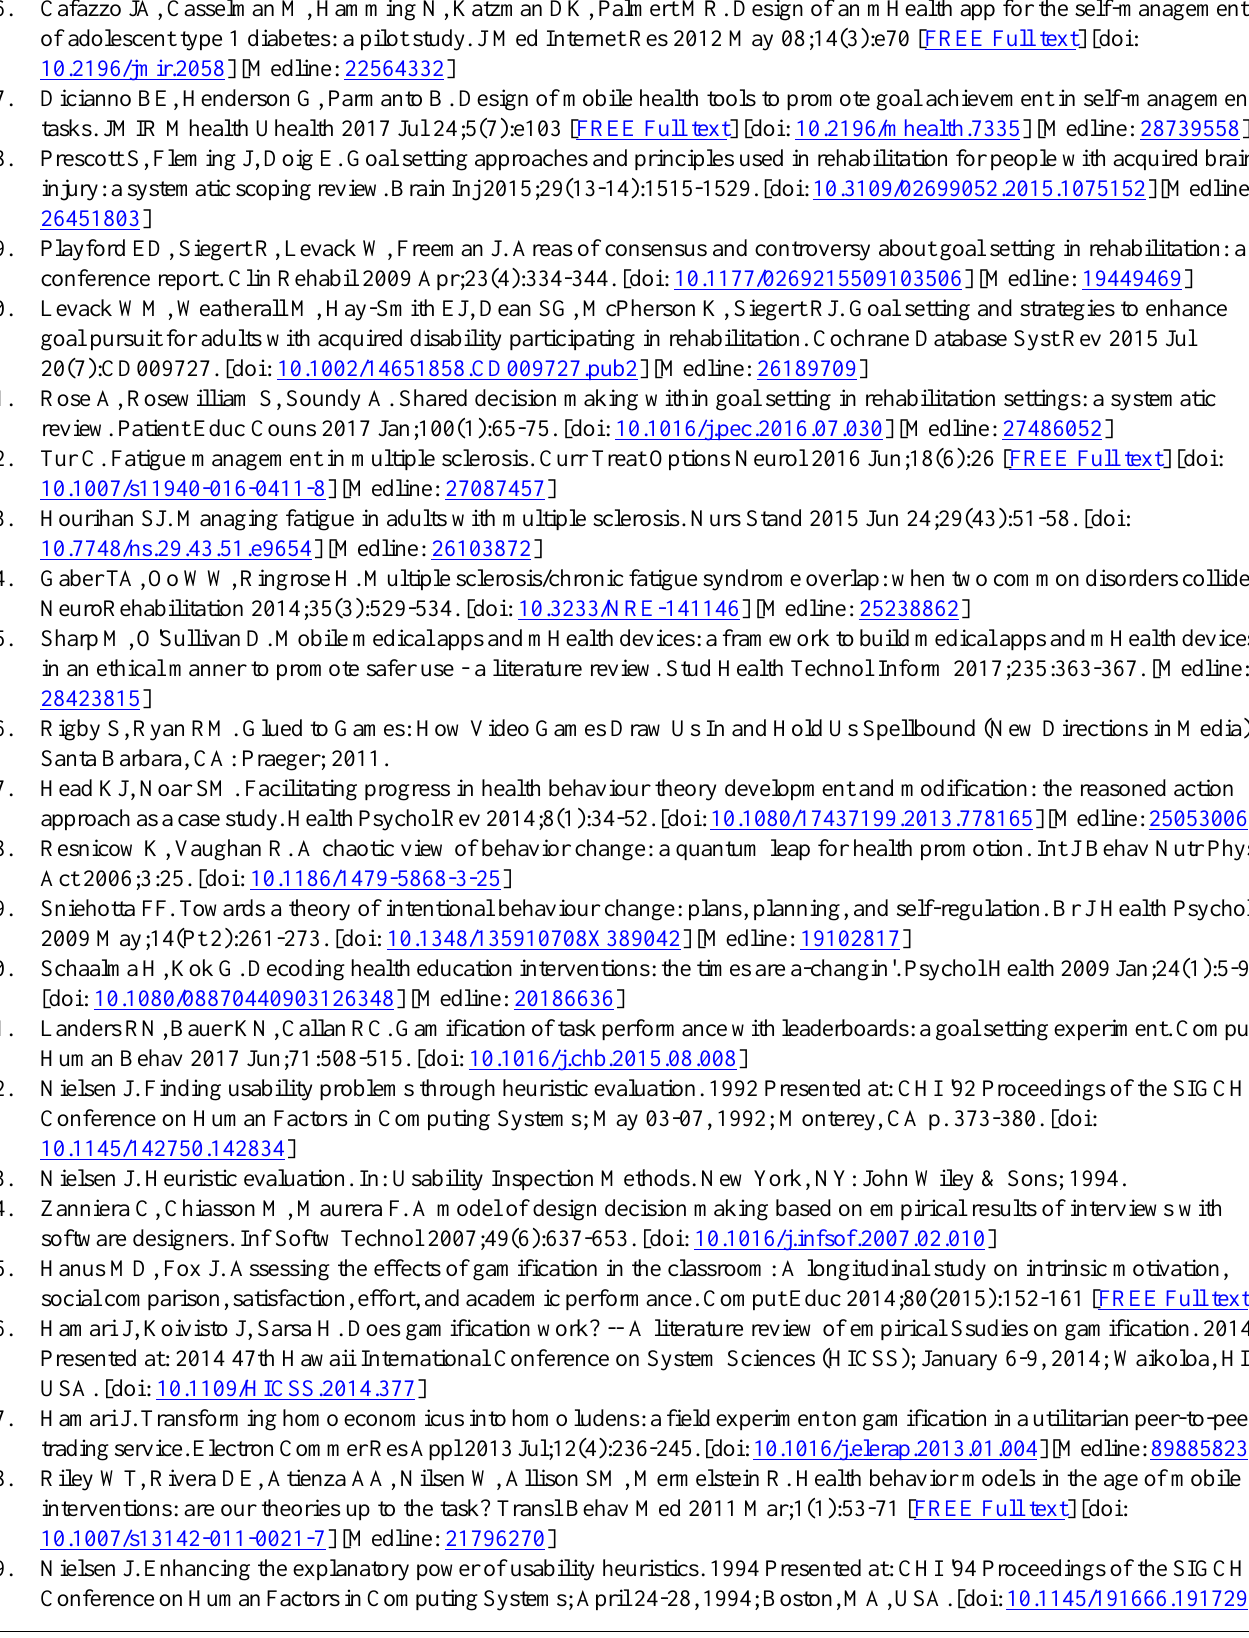
Abbreviations BCM: behavioral change models CFS: Chalder Fatigue